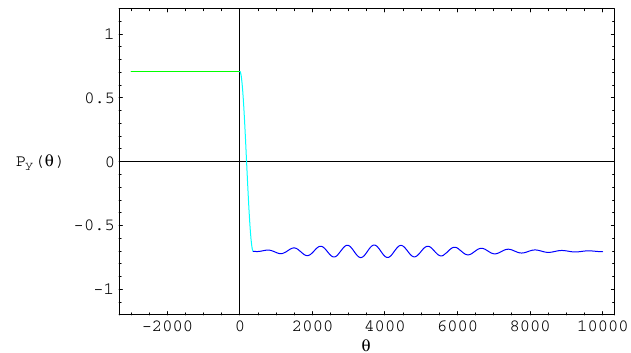
FIG. 8. (Color) Expected polarization when the two resonance jumps constructively interfere, while (cid:5)